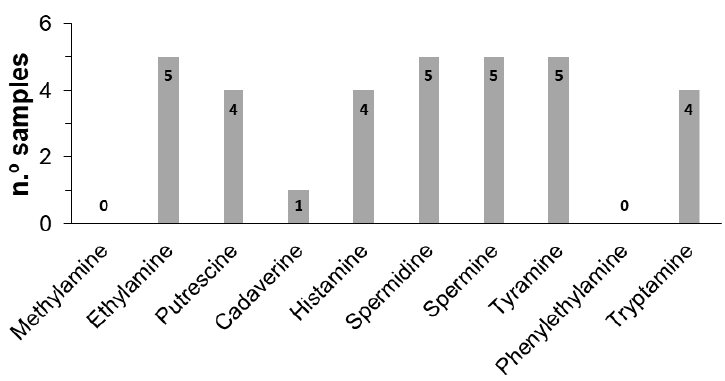
Figure 2. Biogenic amines frequency in the craft beer samples analyzed.